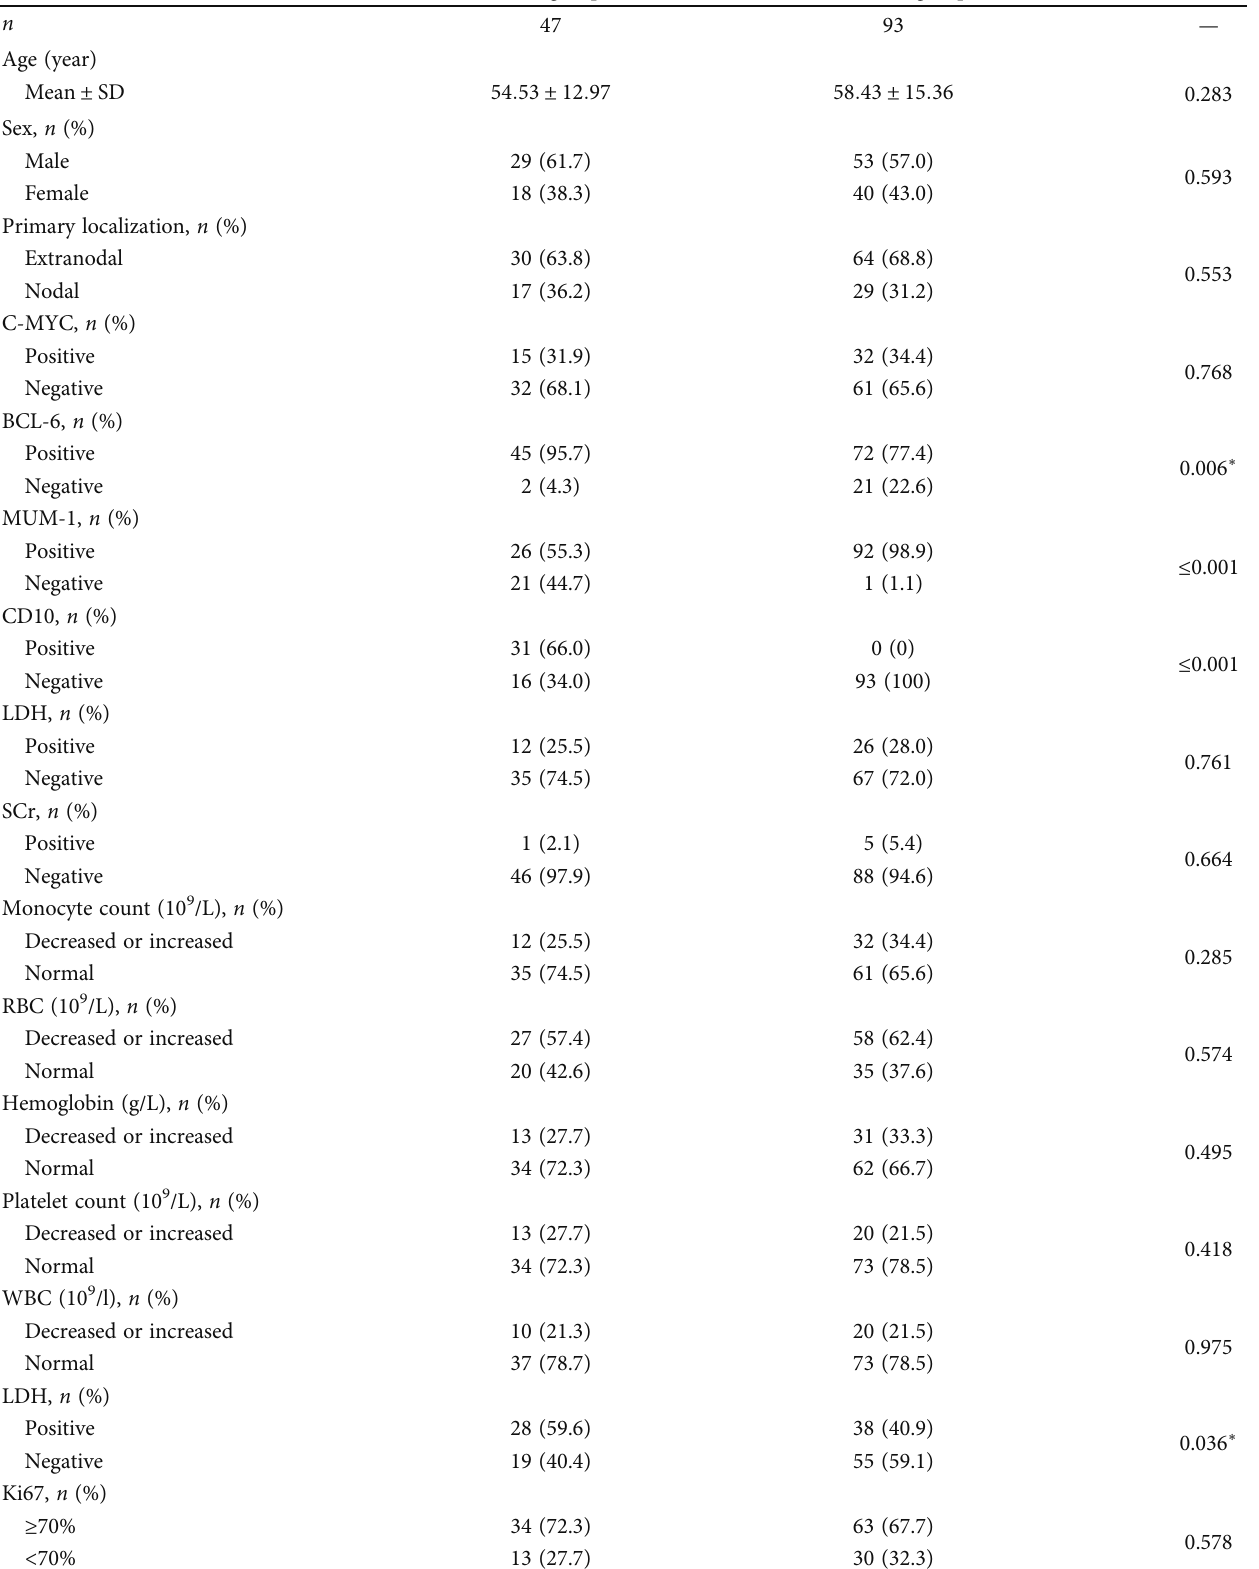
Table 2: The clinicopathological features of 140 DLBCL